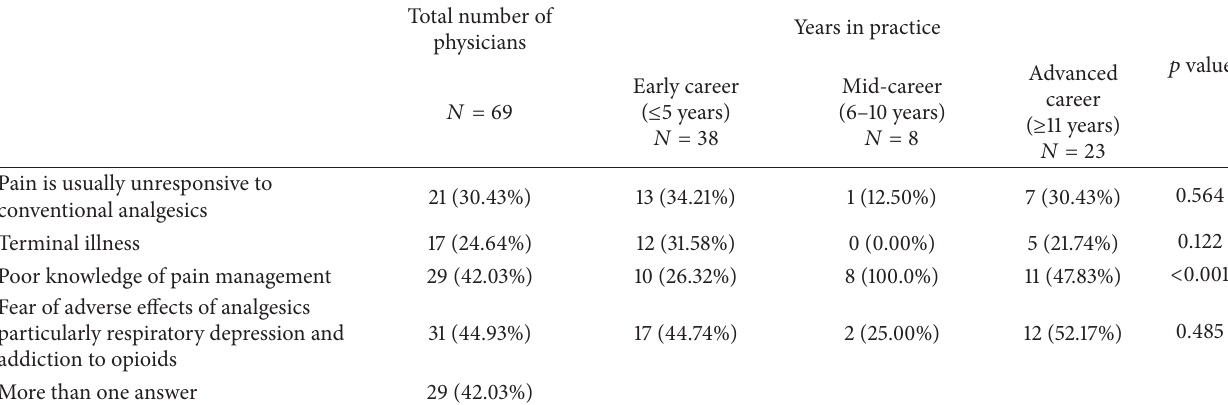
Table 4: Barriers to adequate pain management based on physicians’ years in